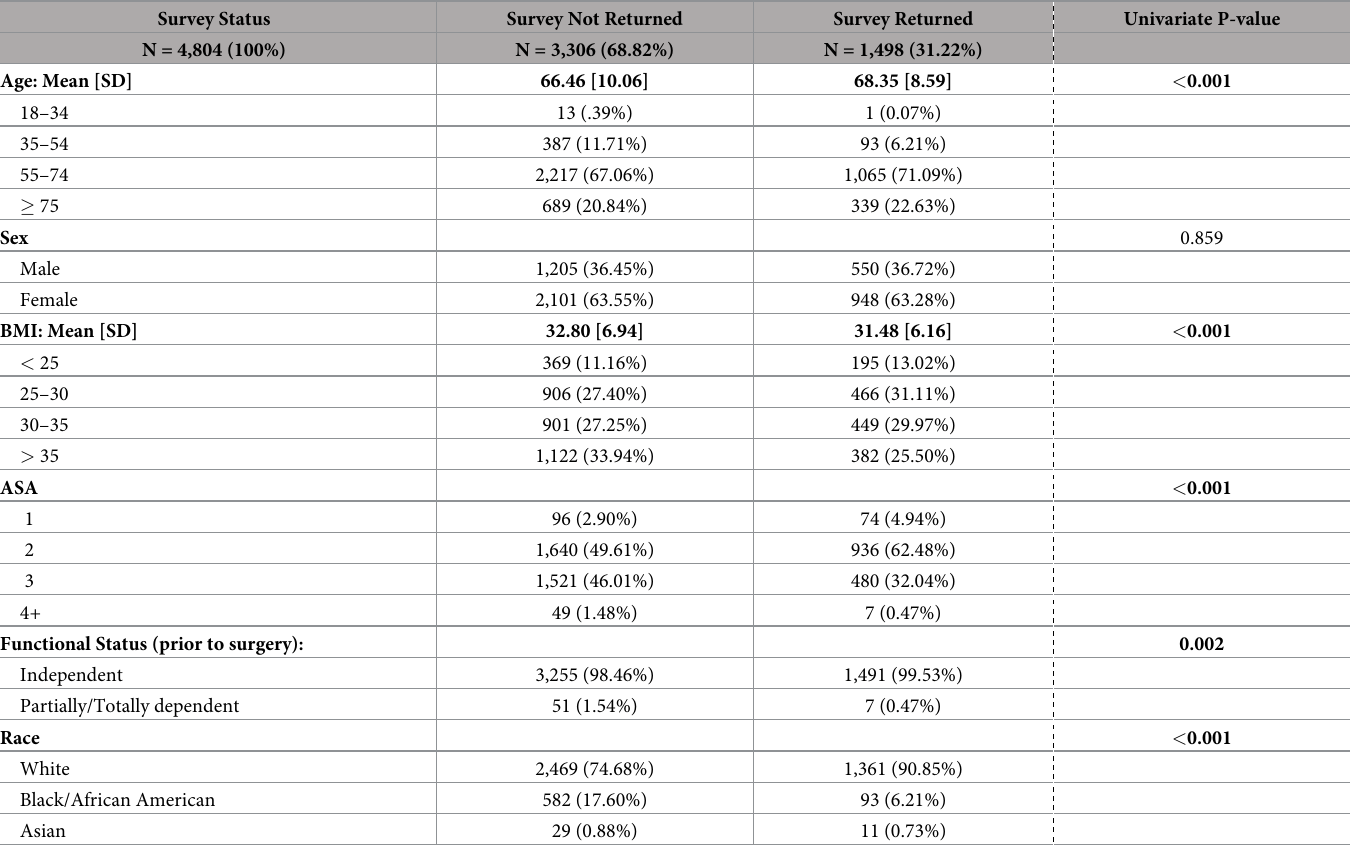
Table 1. Demographics of patients undergoing primary TKA organized by status of HCAHPS survey